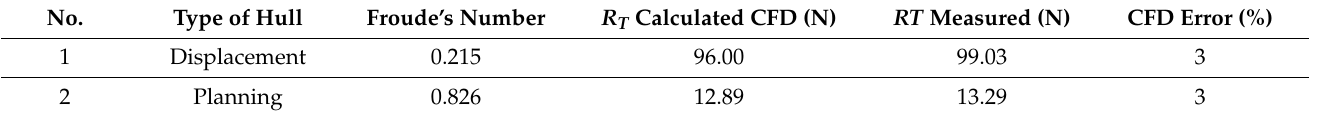
Table 3. Comparison of numerical resistance calculations with model basin measurements [18].